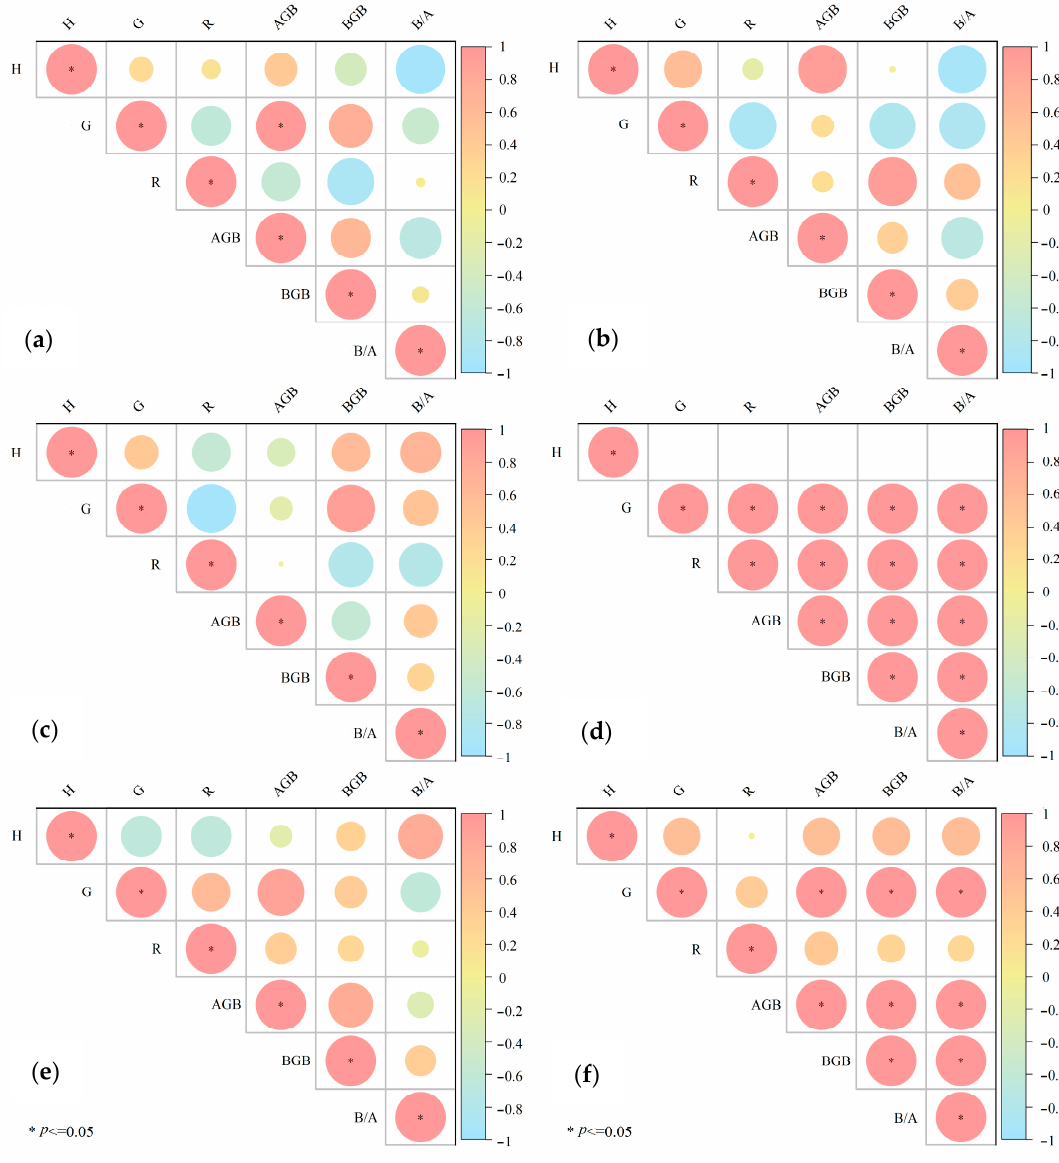
Figure 4. Correlation between P. kansuensis population characteristics. *, a significant correlation at the p < 0.05 level; H, height; G, coverage; R, richness; AGB, aboveground biomass; BGB, belowground biomass; B/A, root/shoot ratio. ( a – f ) is 20–N3, 21–N3, 20–N9, 21–N9, 20–P, 21–P, where 20 = year 2020, 21 = year 2021. N3, N9, P refer to nutrient addition treatments. The size of the circle in the diagram is relevant; the greater the circle, the stronger the correlation, and the weaker the opposite.